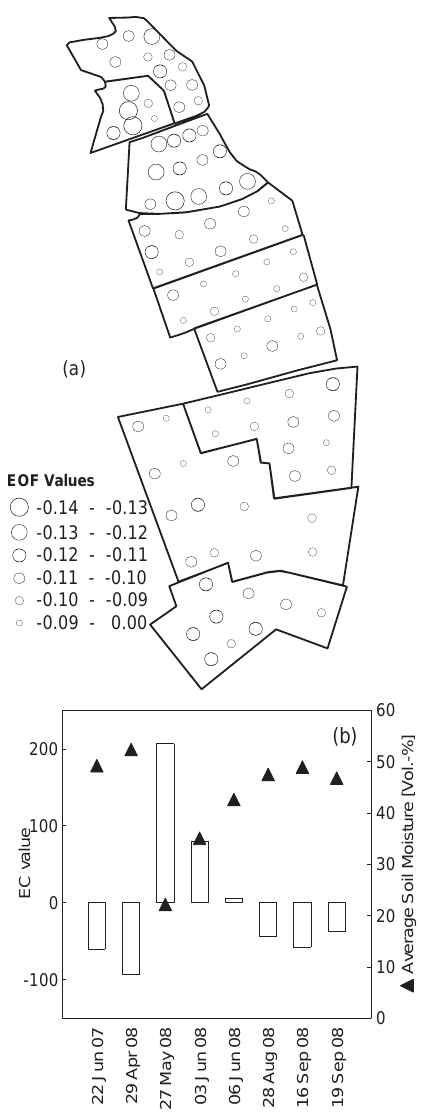
Figure 8. EOF1 (a) and EC1 (b) patterns of the Fig. 8. EOF1 (a) and EC1 (b) patterns of the temporal analysis in temporal analysis in the grassland test site; the the grassland test site; the triangles in (b) represent the average soil triangles in (b) represent the average soil moisture on the different moisture on the different days.